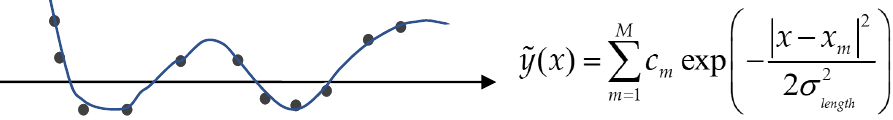
Figure A8. The introduction to Gaussian process regression.